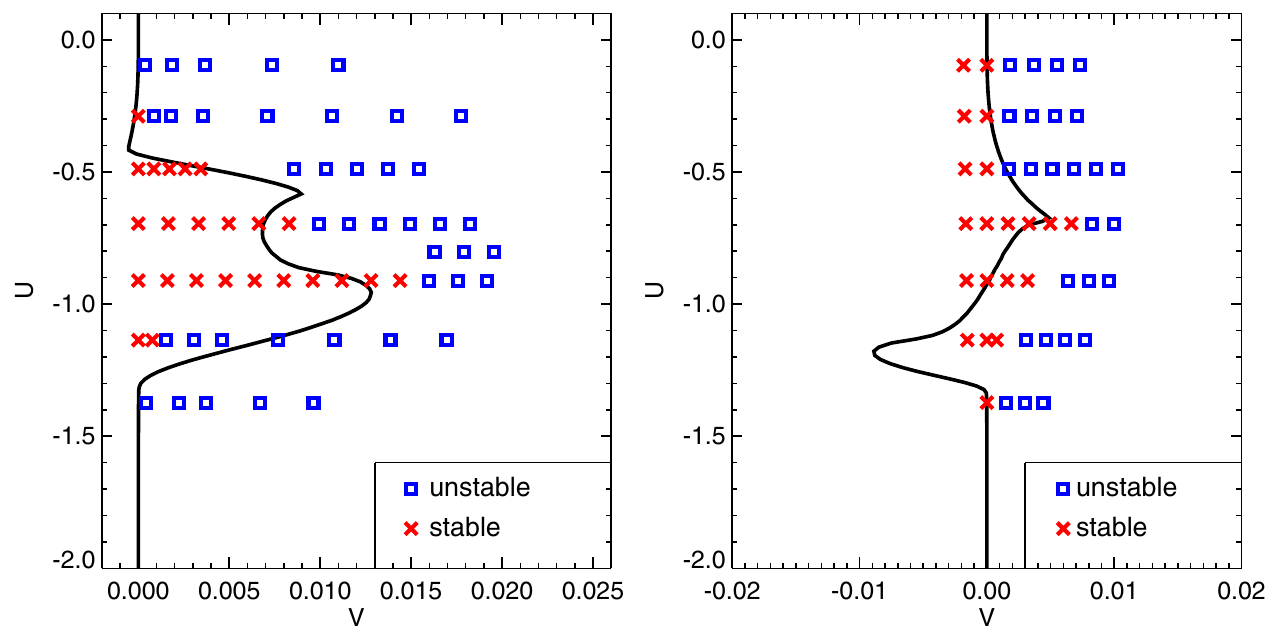
FIG. 4. (Color) Combination of nonlinear space-charge and an octupole with the advantageous polarity (left), disadvantageous polarity (right); simulations are made with self-consistent electric field, transverse waterbag distribution. The symbols are the results of simulations; the lines are stability boundaries from the dispersion